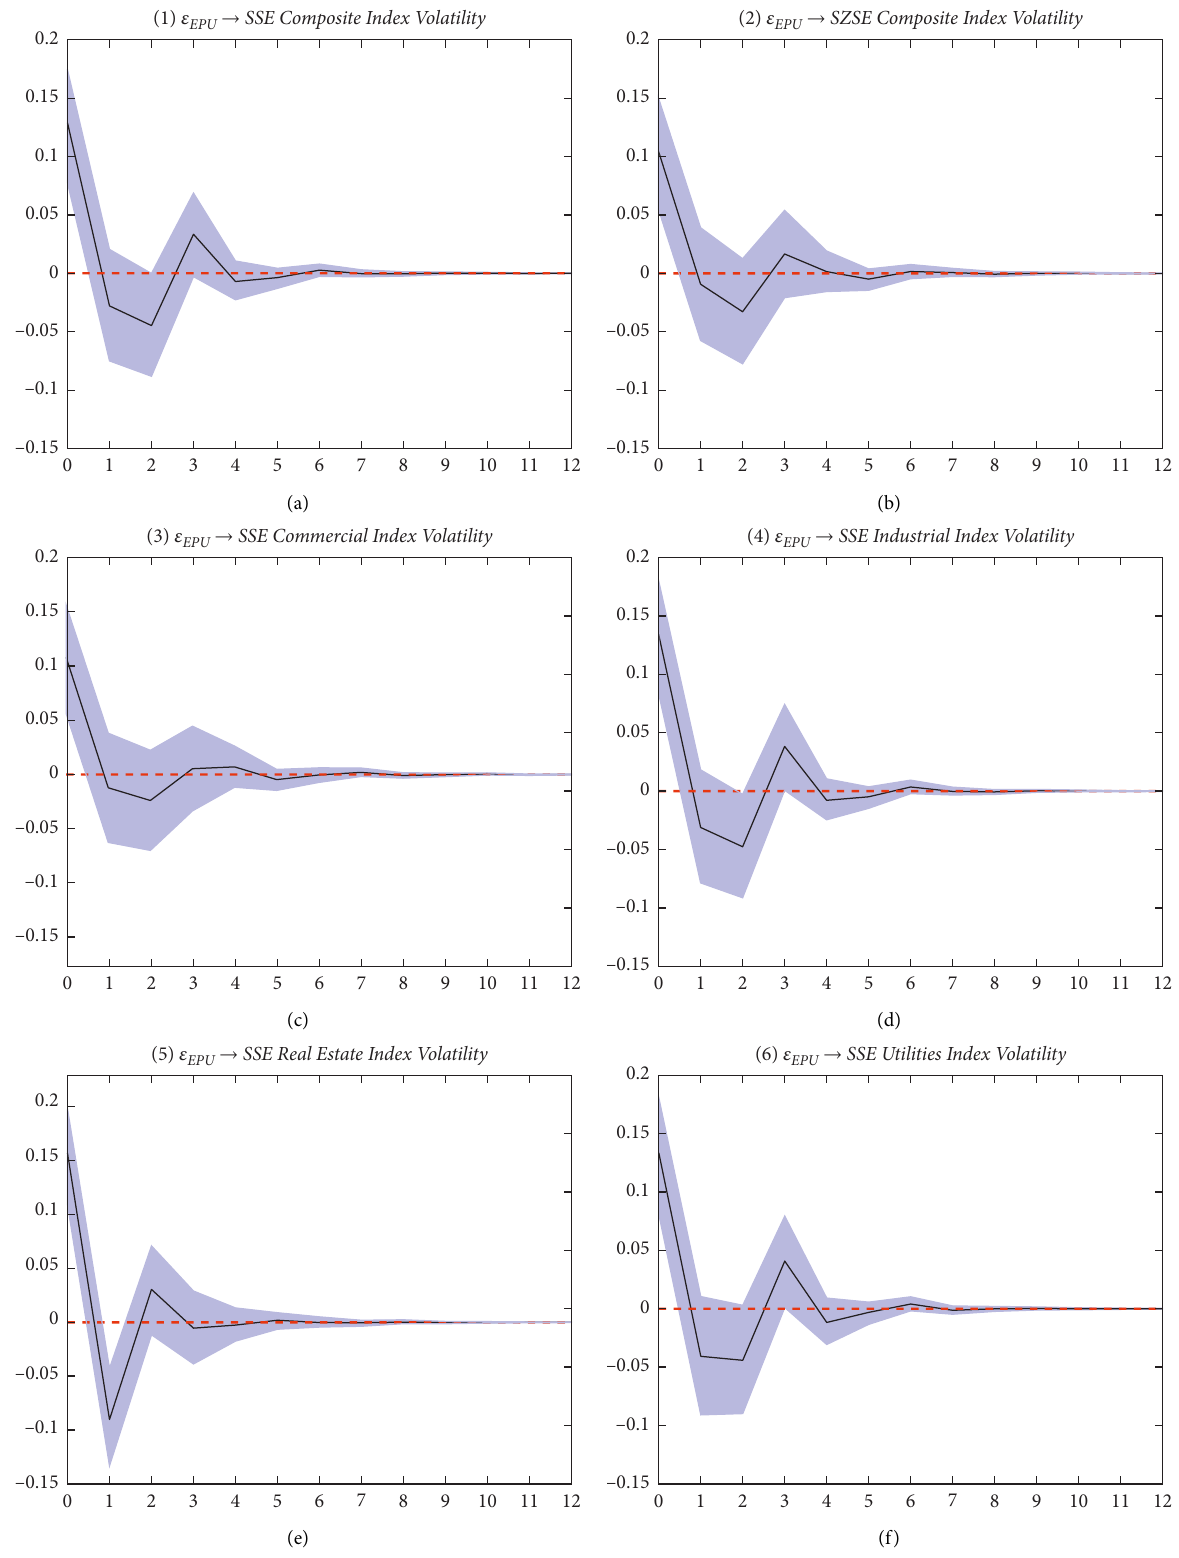
Figure 13: Impulse response of stock market volatility to EPU shocks. Notes: for robustness, we also estimate the SVAR models with lag order 2, inspired by the research of Huang and Luk [1]. The solid black lines represent the median impulse response. The light-colored region represents 68% of error bands. Each period is a